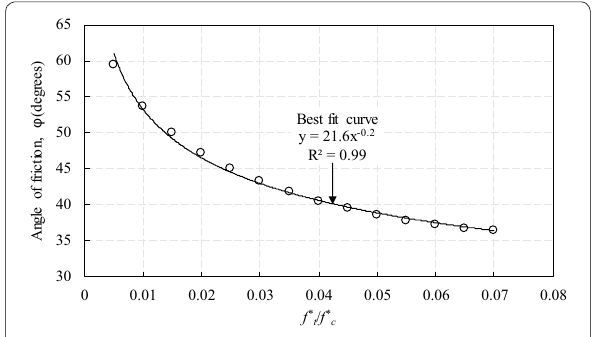
Fig. 7 Modeling of φ for LWAC‑BS.